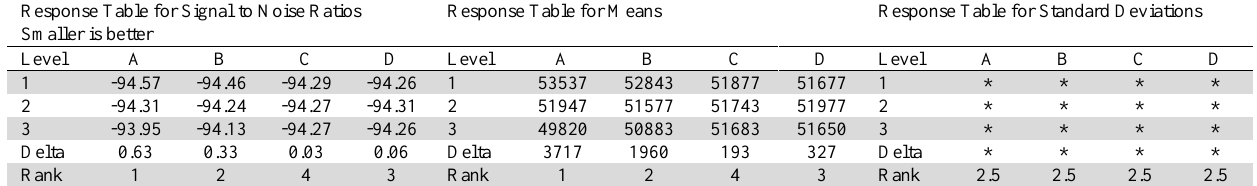
Analyzing results of implementing the designed experiments (Taguchi Analysis: R versus A, B, C, D) Response Table for Signal to Noise Ratios Response Table for Means Response Table for Standard Deviations Smaller is better